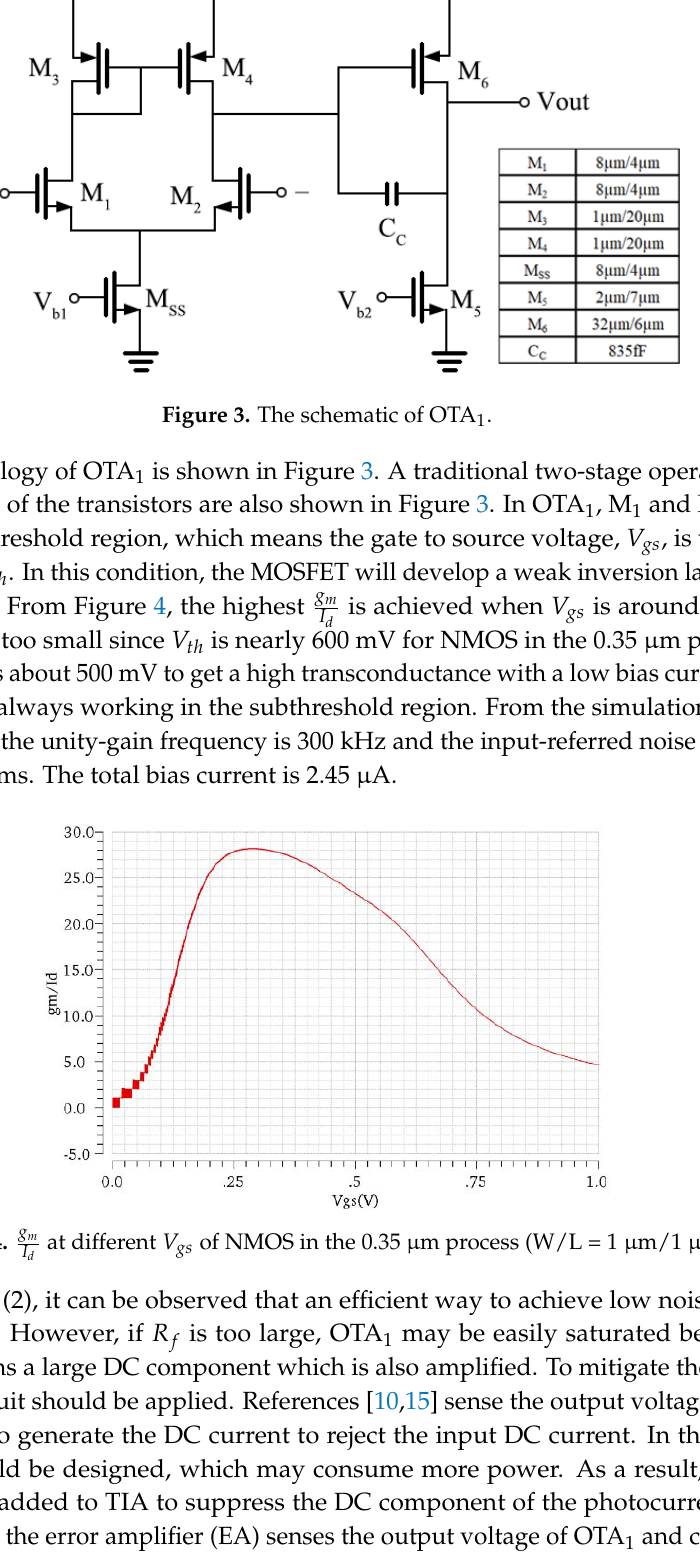
Figure 2. In the loop, the error amplifier (EA) senses the output voltage of OTA 1 and controls the